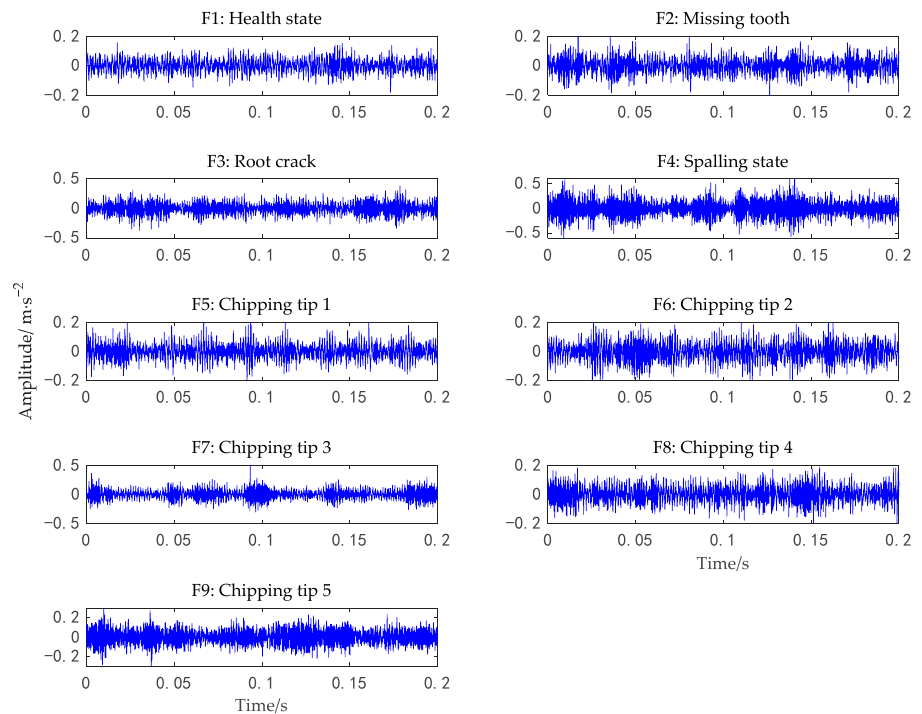
Figure 12. Raw vibration signals of nine gear data.